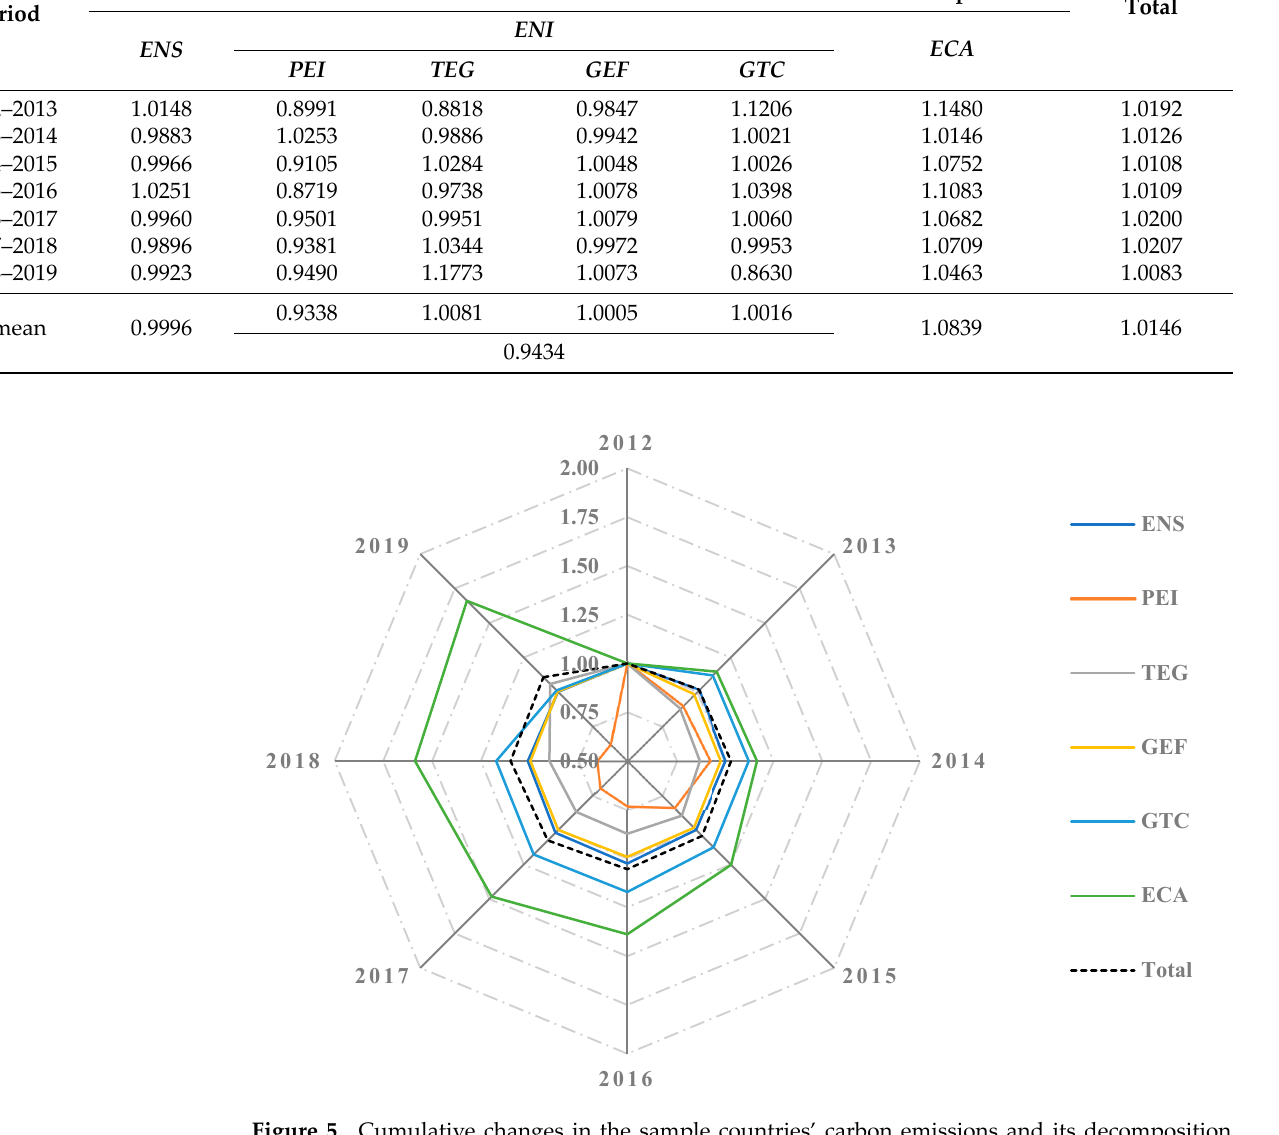
Figure 5. Cumulative changes in the sample countries’ carbon emissions and its decomposition,